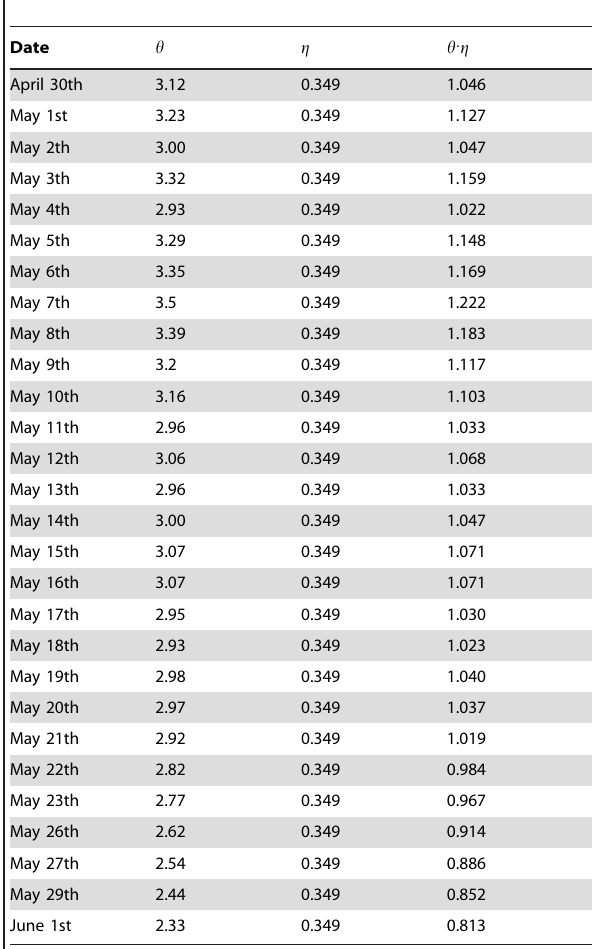
Table 1. The empirical results of the parameters h and g , and their relevance at the early time(the period between April 30th and June 1st, 2009), using 2009 Pandemic A(H1N1) data collected by the